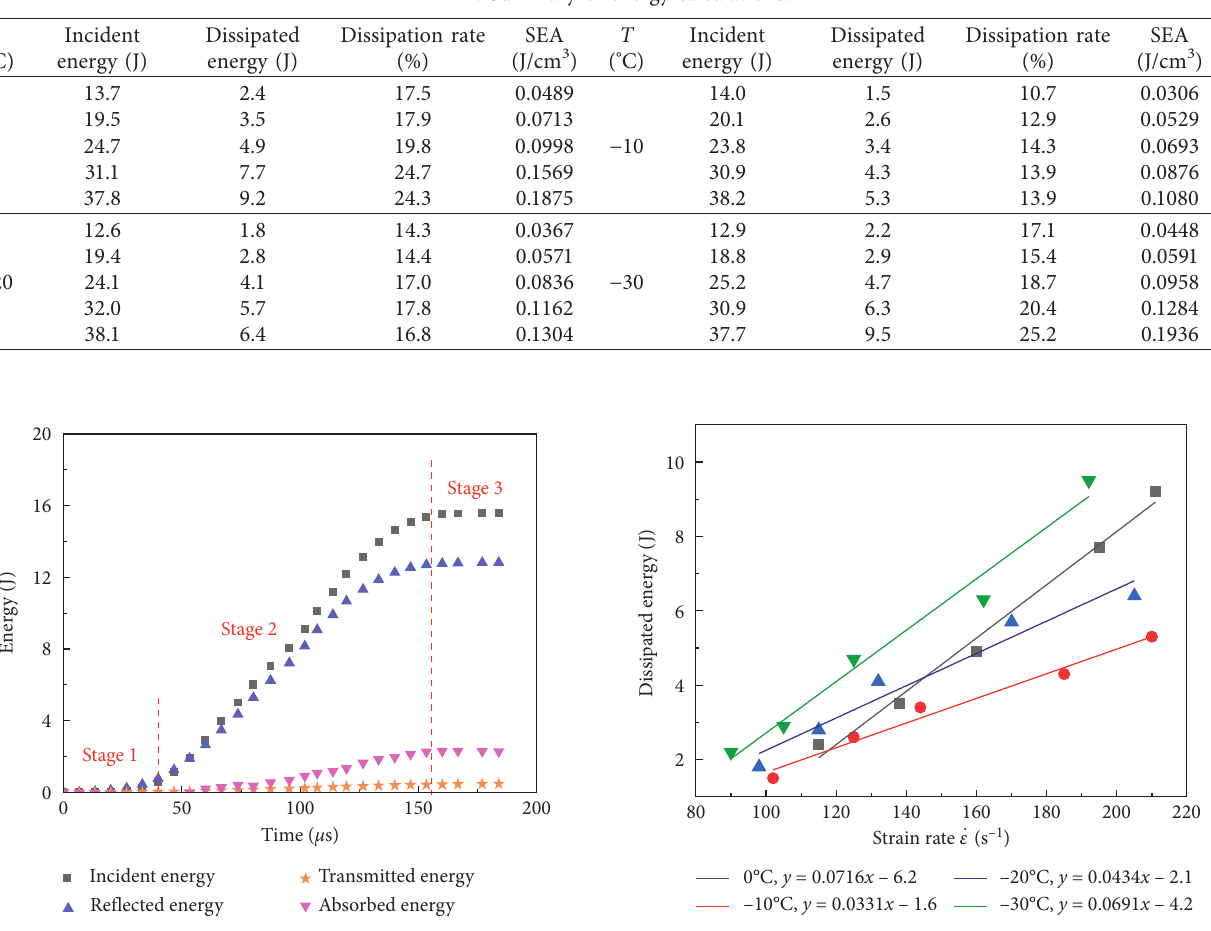
Figure 7: Energy time-history curve of saturated frozen sandstone under impact.